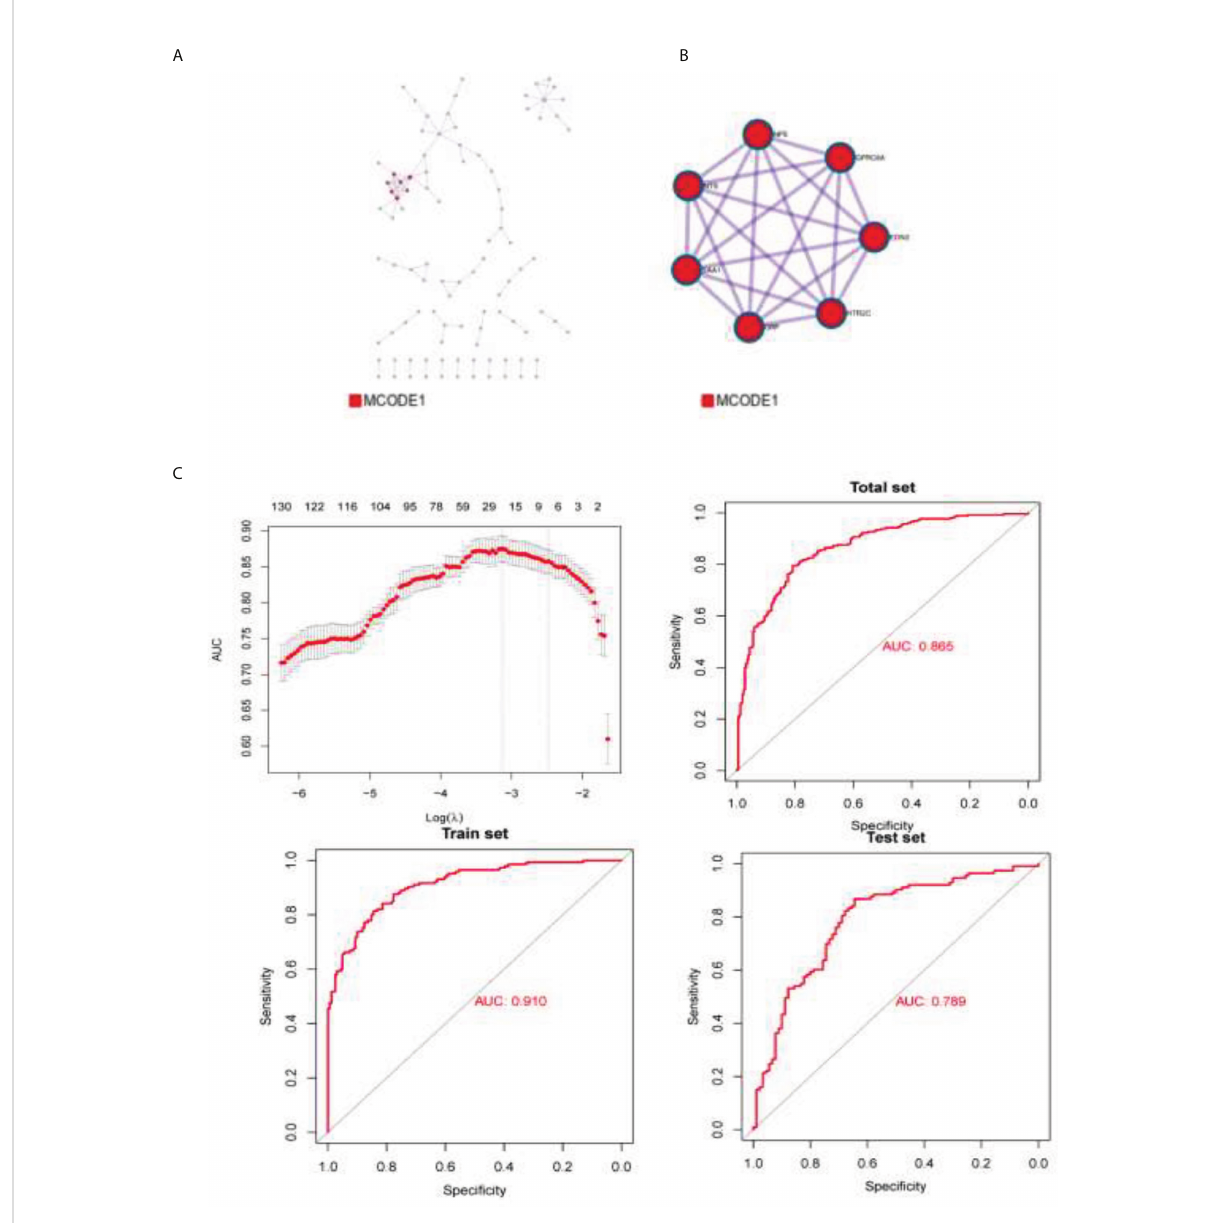
FIGURE 5 The densely connected network components in this protein interaction network. (A) BioGrid6, InWeb_IM7, and OmniPath8 were used to build protein – protein interaction fi gure. (B) Molecular Complex Detection algorithm was used to obtain the densely connected network components of this protein interaction network. (C) AUC of the prediction